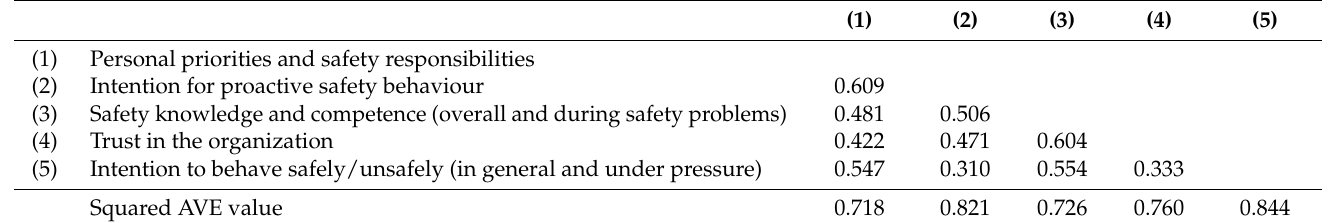
Table 7. All squared values of AVE are higher than inter-construct correlations. Table 7. Results CFA—Psychological domain (n = 444)—assessment of discriminant validity (com- parison of squared average variance extracted and constructs’